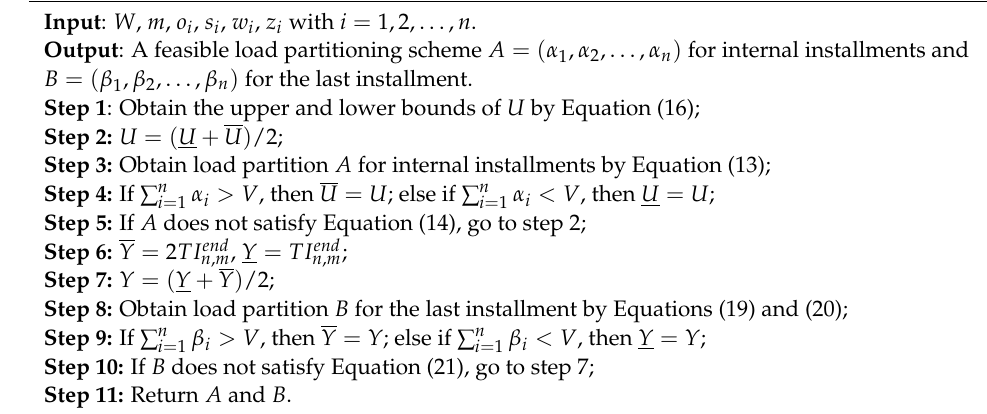
Algorithm 1 A Heuristic Algorithm for Scheduling Coarse-Grained Divisible Loads